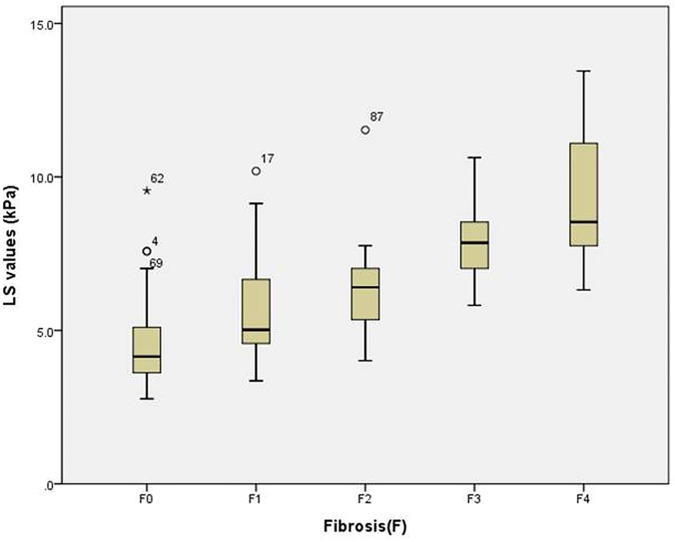
Box-and-whisker plot shows the liver stiffness (LS) values at each fibrosis staging.The boxes represent LS values from the 25th to 75th quartile, and the lines at the center of the boxes indicate the median. The whiskers represent the 9th and 91st percentiles. LS values are expressed in kilopascals.